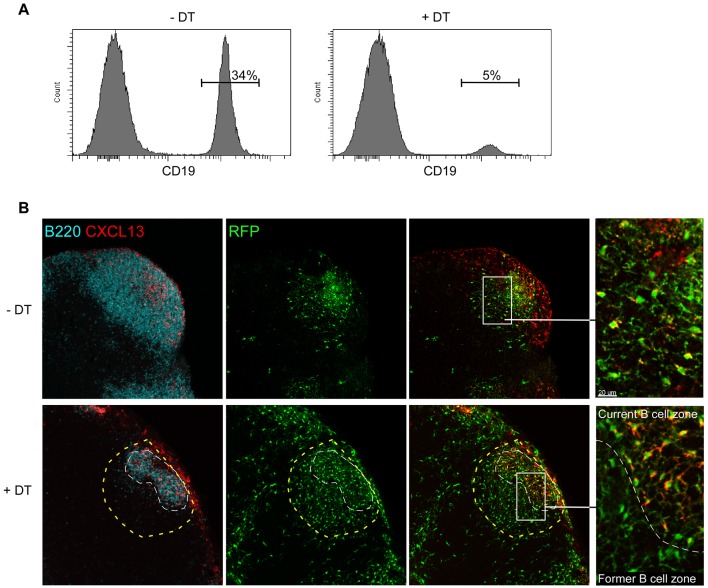
Acute B cell deletion abrogates CXCL13 staining in converted CD21− RFP+ stromal cells.CD21cre-RFP mice were irradiated and reconstituted with bone marrow cells isolated from CD21cre-DTR mice. Reconstituted chimeras were injected with an emulsion of CFA/PBS in the ears. Three weeks later, mice were treated or not with DT for 3 consecutive days. The fourth day, ear draining LNs were harvested and either analyzed by flow cytometry (A) or sectioned and imaged by confocal microscopy (B). (A) Dot plots of ear draining LNs showing B cell deletion upon DT treatment. (B) Confocal images of LN tissue sections stained for B220 (blue) and CXCL13 expression (red). RFP+ cells appear in green. Inserts display high magnifications of the B cell areas. The yellow dashed line delineates the approximate size of the B cell follicle prior DT injection (see Materials and Methods), while the white dashed line delineates the boundary of the residual B cell follicle. Data are representative of three different experiments (two mice per experiment).